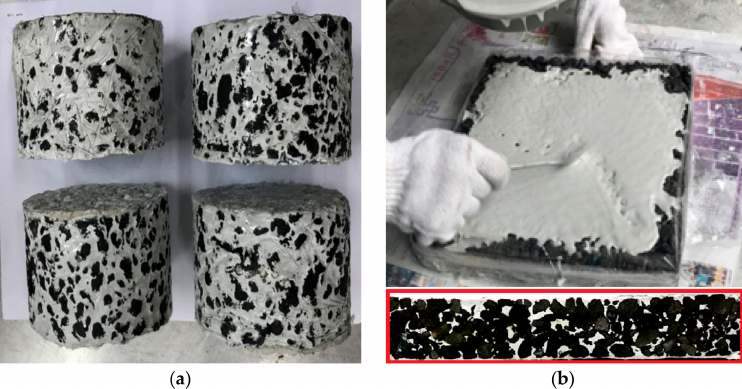
Figure 6. Grouting of the SFP material. ( a ) Marshall specimen grouting; ( b ) Rutting specimen